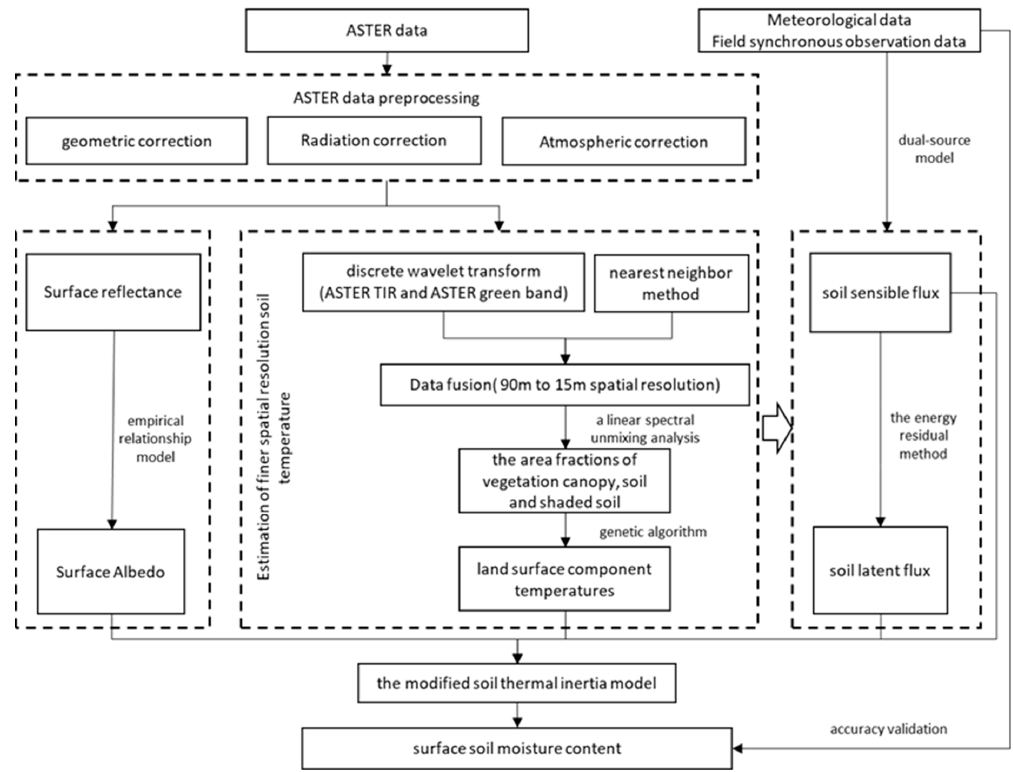
Figure 1. The flow chart of obtaining soil moisture content (SMC) from the modified soil thermal inertia (STI) model.